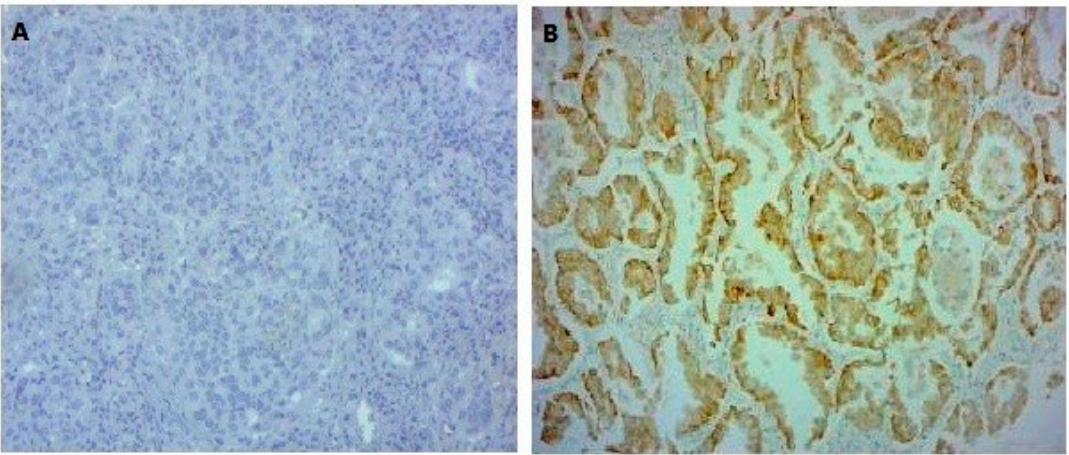
Figure 2. EGFR immunohistochemistry (IHC) staining in lung adenocarcinoma: ( A ) Negative immunostaining of EGFR (200 × ), ( B ) EGFR cytoplasmic IHC staining in lung adenocarcinoma (LAD). Strong positivity of EGFR in cytoplasm [3 + , 100%] (200 × ).